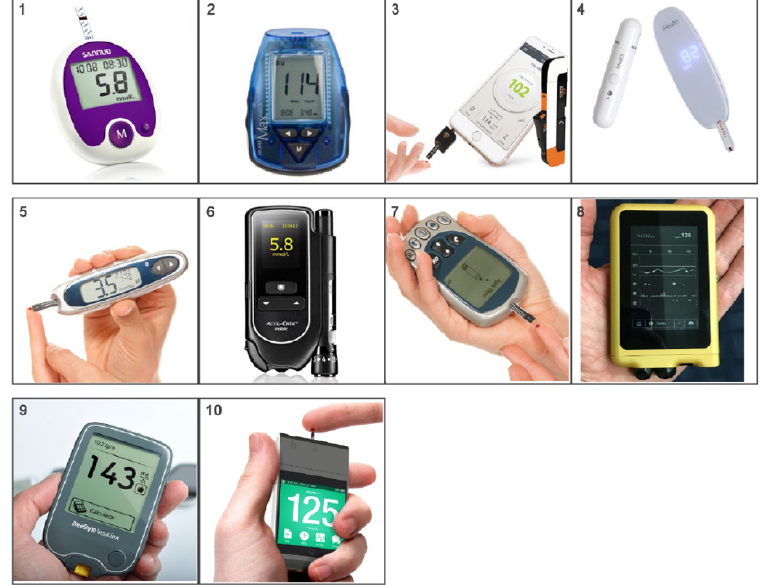
Figure 3: Visuals of the 10 POCT devices using focus group